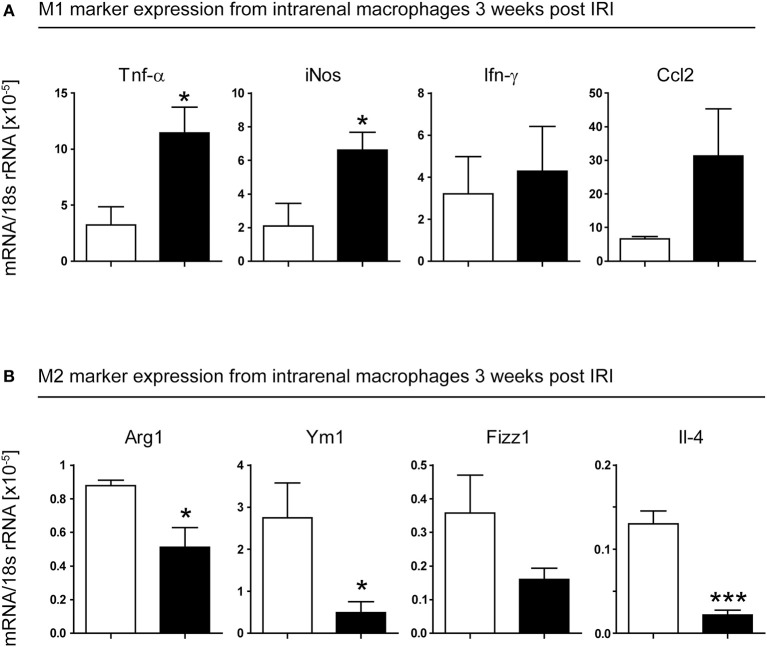
Unilateral IRI was induced in 4- to 6-week-old WT (white bars) and IRF4-deficient mice (black bars). Operated kidneys were harvested 21 days after induction of the model. CD11b+ cells were isolated from kidneys by MACS magnetic separation. Cells were checked for purity and lysed for RNA extraction. RT-PCR of the indicated genes was performed and normalized per 18S rRNA. *p < 0.05.